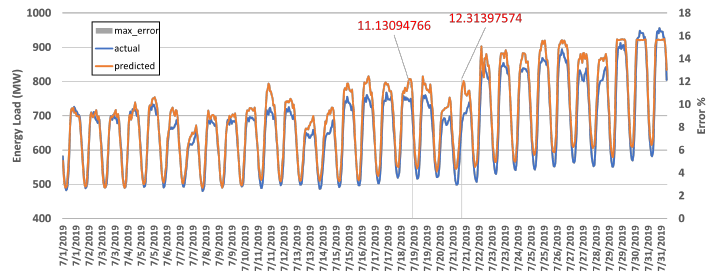
Figure 17. Peak errors recorded in the month of July